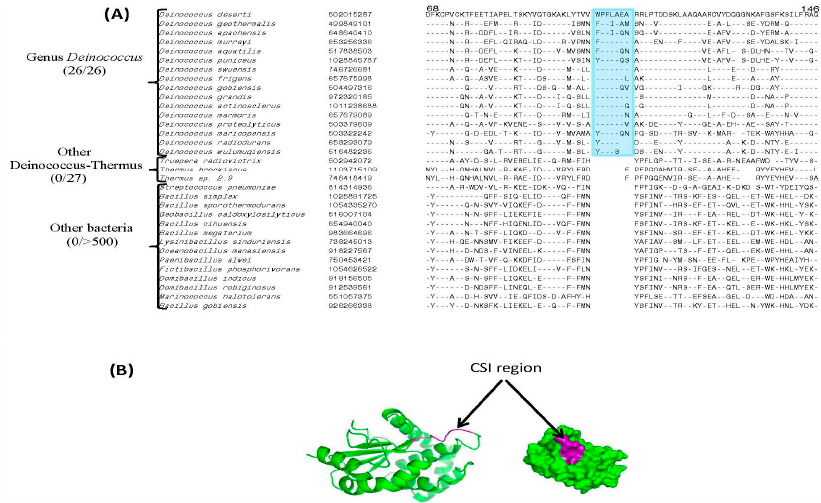
Figure 7. ( A ) Partial sequence alignment of the DsbA oxidoreductase protein showing a 5–7 amino acid insertion in a conserved region that is specific for Deinococcus species; ( B ) Location of the CSI in the modeled structure of DsbA protein from D. deserti constructed using the template structure of DsbA protein from Bacillus subtilis (PDB id: